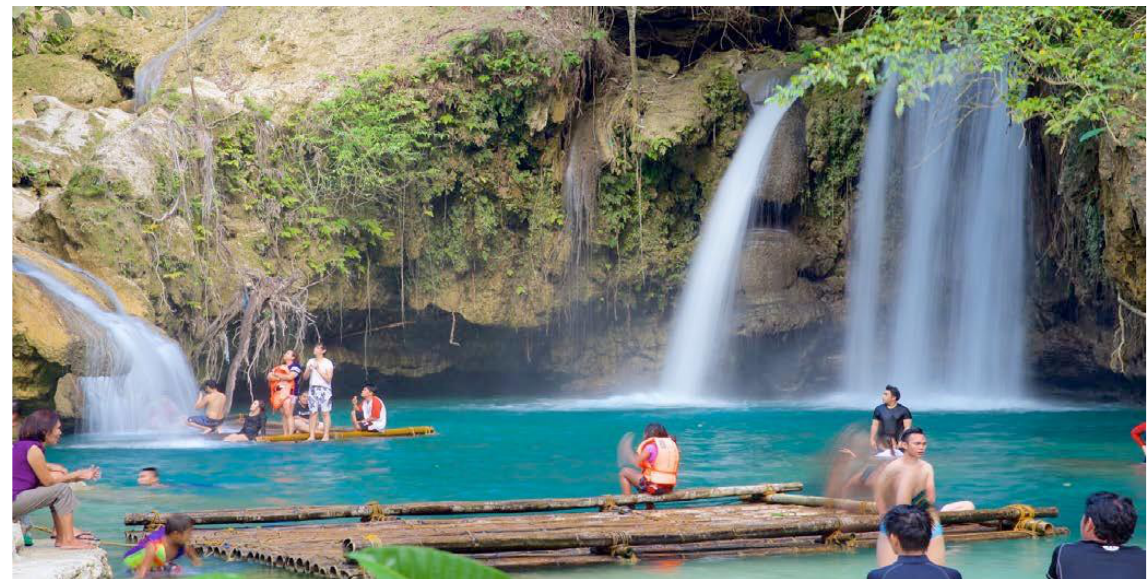
Figure 4. In the picture are people who enjoyed Kayaking out of a